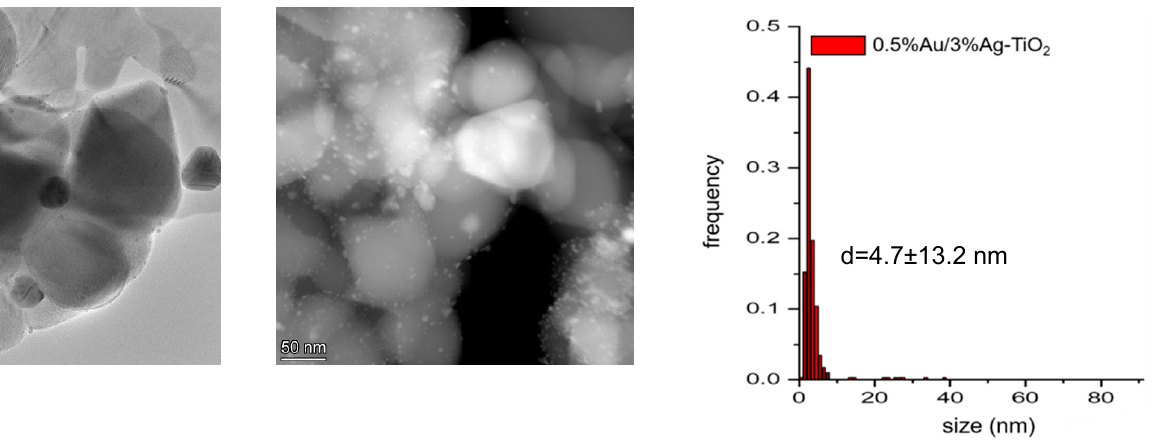
Figure 8. Representative TEM and HAADF images of the 0.5%Au/3%Ag-TiO 2 sample and particle size distribution.